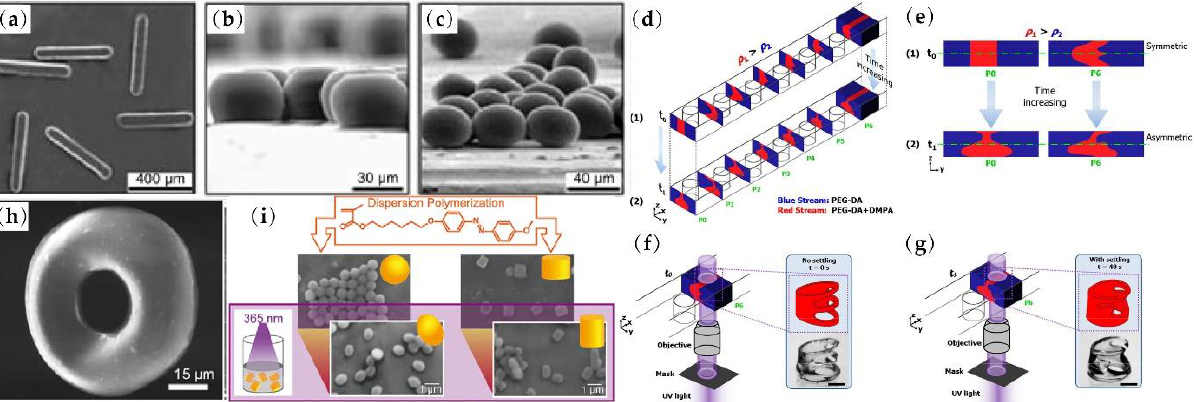
Figure 2. Non-spherical particle shapes for fabrication: ( a ) rods; ( b ) disks; ( c ) ellipsoids from droplet microfluidics. 4D optofluidic fabrication with ( d ) cross sections of UV-curable fluid stream passing through sequential six pillars, ( e ) cross sections of beginning and after stream shape forming with symmetric or asymmetric flows, 3D particle creation with ( f ) symmetric flow and ( g ) asymmetric flow through optofluidic fabrication. ( h ) Typical toroidal polymer particle fabricated through solidification and ( i ) different shaped non-spherical uniaxial azobenzene polymer particles under UV- or white-light irradiation. Figures ( a – c ) are reprinted with permission from [40], Copyright 2005 John Wiley and Sons. Figures ( d – g ) are reprinted with permission from [41], Copyright 2020 RSC Publishing. Figure ( h ) is reprinted with permission from [42], Copyright 2009 John Wiley and Sons. Figure ( i ) is reprinted with permission from [43], Copyright 2020 American Chemical Society.